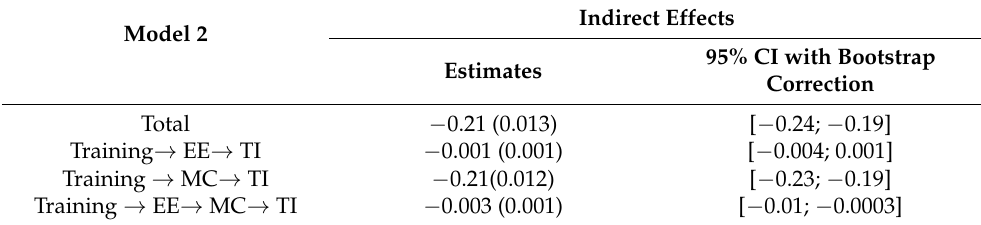
Table 6. Indirect effects of Model 2.